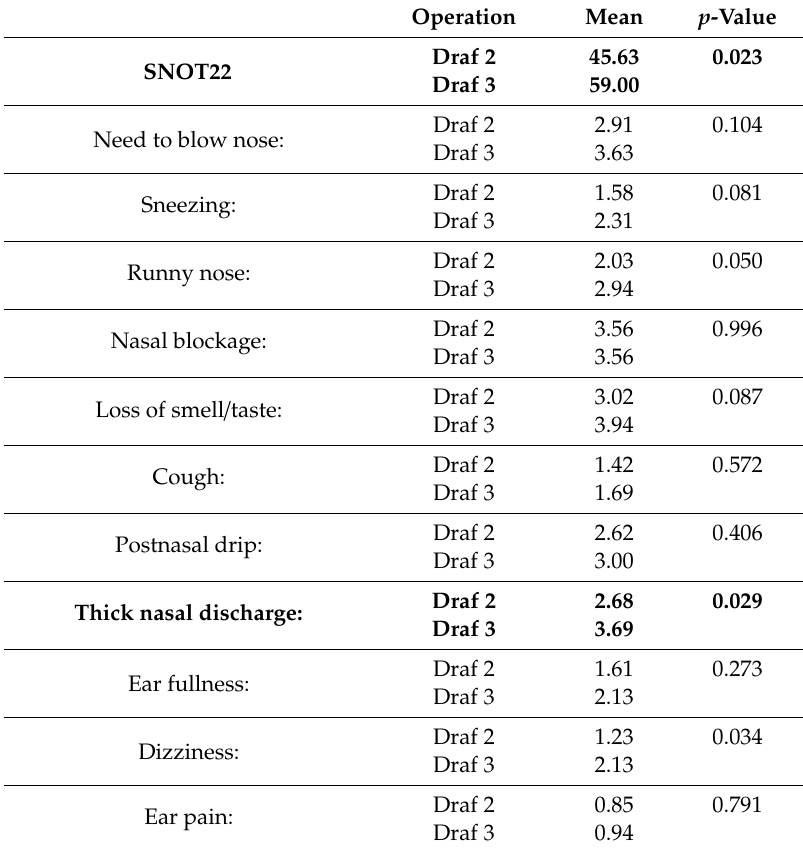
Table 2. Preoperative grades per symptoms—included in SNOT-22 questionnaire. Comparison between Draf 2 / Draf